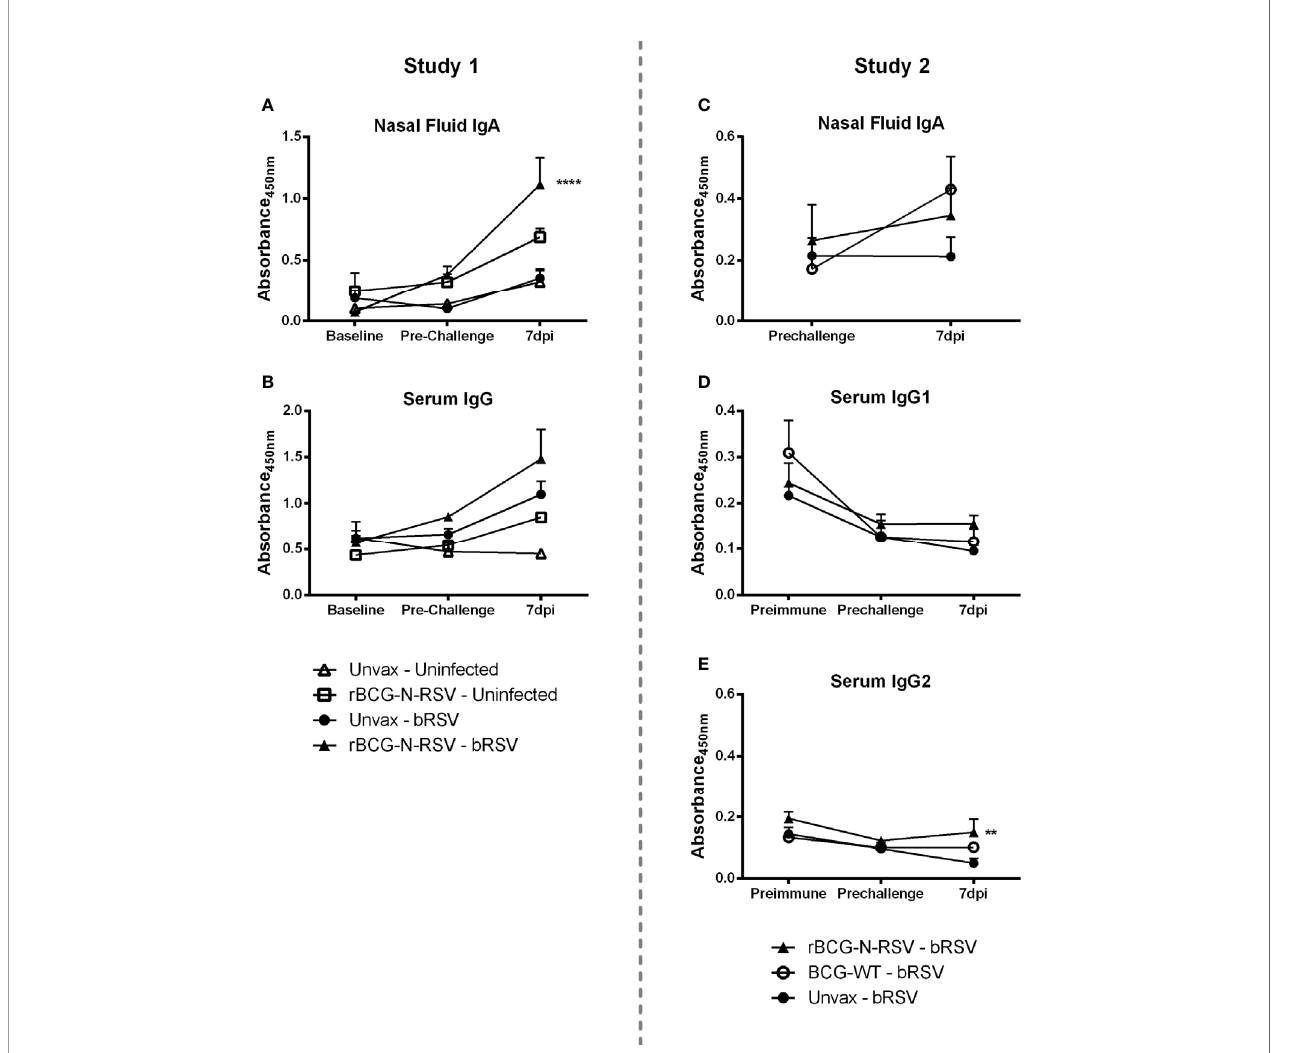
FIGURE 6 | rBCG-N-hRSV vaccinated calves mount an amnestic virus-speci fi c IgA and IgG2 response in the respiratory tract and peripheral blood, respectively. (A, C) Nasal fl uid samples were collected and analyzed for bRSV-speci fi c IgA by indirect ELISA prior to immunization (baseline), at pre-challenge, and on day 7 post- infection. Data represented as mean ± SEM. No signi fi cant differences were detected in IgA levels at baseline and pre-challenge between any group. ****p<0.0001 between rBCG-N-hRSV-vaccinated – bRSV and unvaccinated – bRSV groups on day 7 post infection as determined by 2-way ANOVA followed by Sidak ’ s multiple comparisons test. (C, E) Serum samples were collected and analyzed for IgG ( B , Study 1), IgG1, and IgG2 ( D, E , Study 2). **p < 0.01 between rBCG-N-hRSV-vaccinated – bRSV and unvaccinated – bRSV groups on day 7 post-infection as determined by 2-way ANOVA followed by Sidak ’ s multiple comparisons